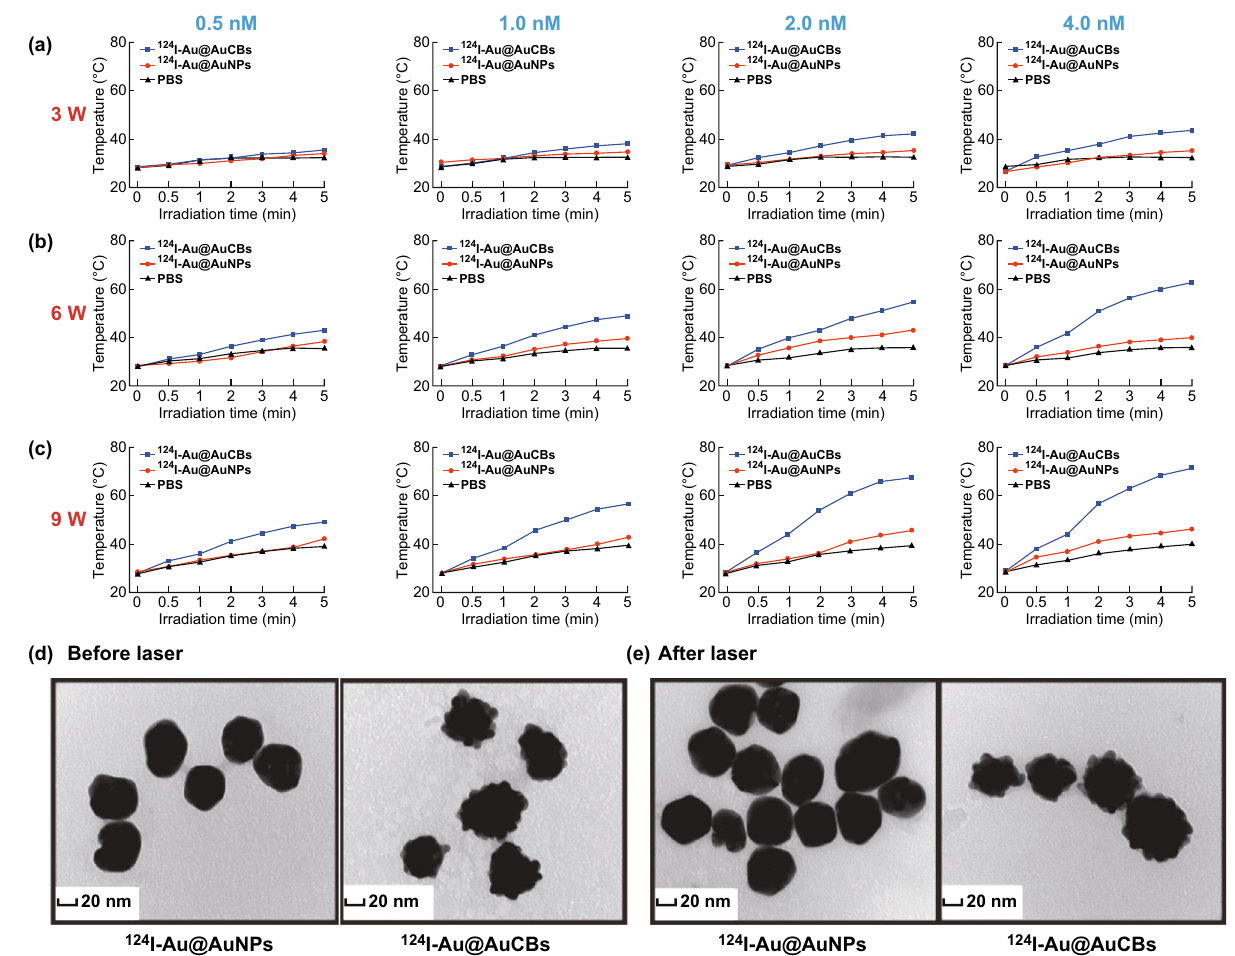
Fig. 2 Photothermal conversion properties of 124 I‑Au@AuCBs. a – c Temperature change of PBS, 124 I‑Au@AuNP, and 124 I‑Au@AuCB solutions after irradiation with an NIR laser for 5 min at varying power levels (3, 6, and 9 W cm −2 ) and particle concentrations (0.5, 1.0, 2.0, and 4.0